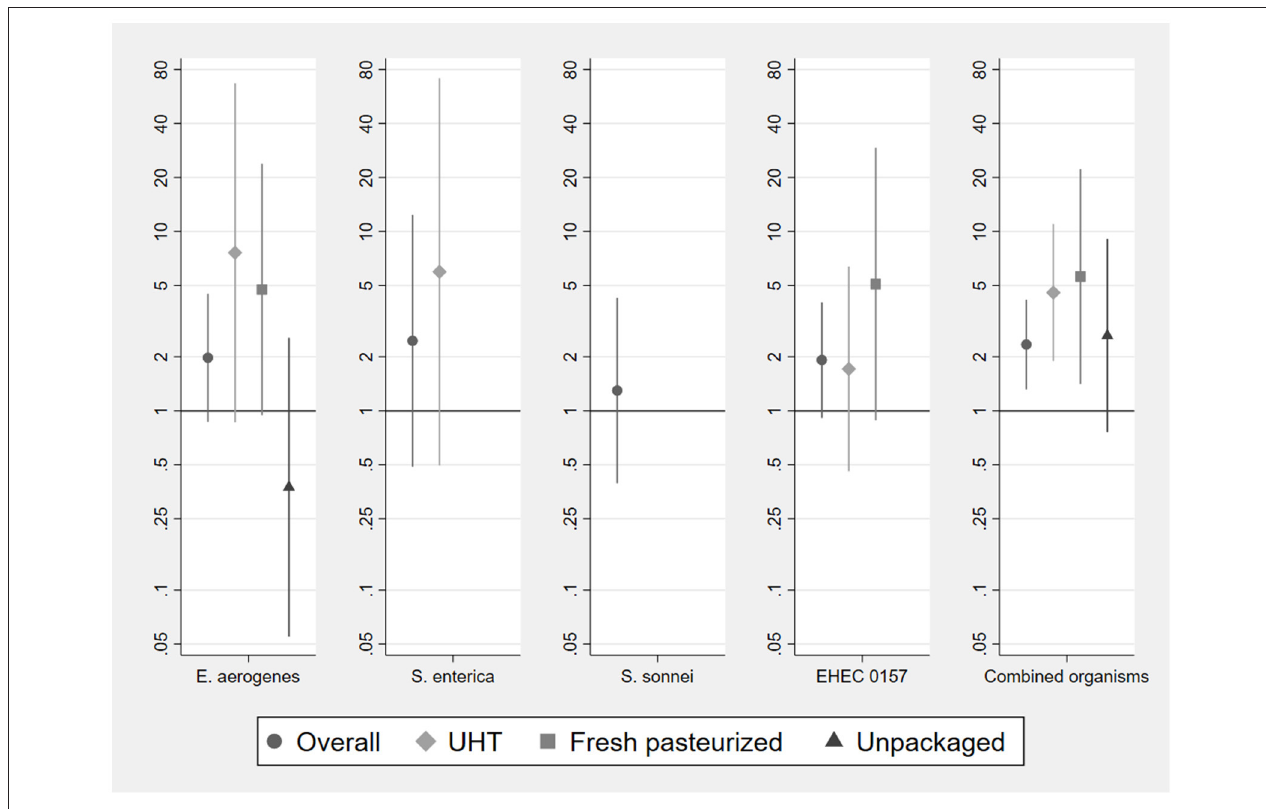
FIGURE 4 | Odds ratios of bacterial detection in infant food based on vendor milk contamination status by type of milk used to prepare food. Samples sizes for analysis of individual organisms are 187 (overall, pooling milk types), 132 (UHT), 36 (fresh pasteurized), 19 (unpackaged). Sample sizes for analysis of combined organisms using stacked observations are 748 (overall), 528 (UHT), 144 (fresh pasteurized), 76 (unpackaged). Odds ratios for the presence of S. enterica and S. sonnei in fresh pasteurized and unpackaged milk, of S. sonnei in long-life milk, and for the EHEC 0157 phenotype in unpackaged milk, could not be estimated due to lack of variation in the outcome conditional on presence of organism in vendor sample. Error bars represent 95% confidence